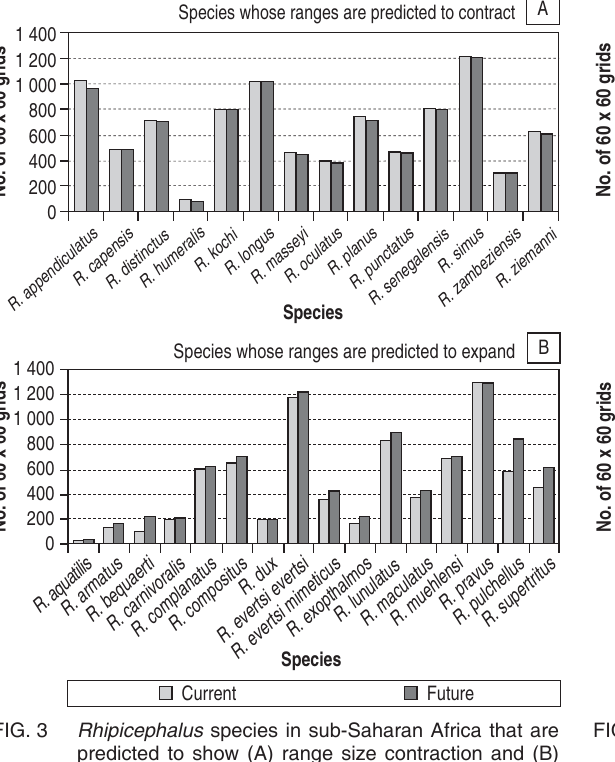
FIG. 3 Rhipicephalus species in sub-Saharan Africa that are predicted to show (A) range size contraction and (B) range size expansion